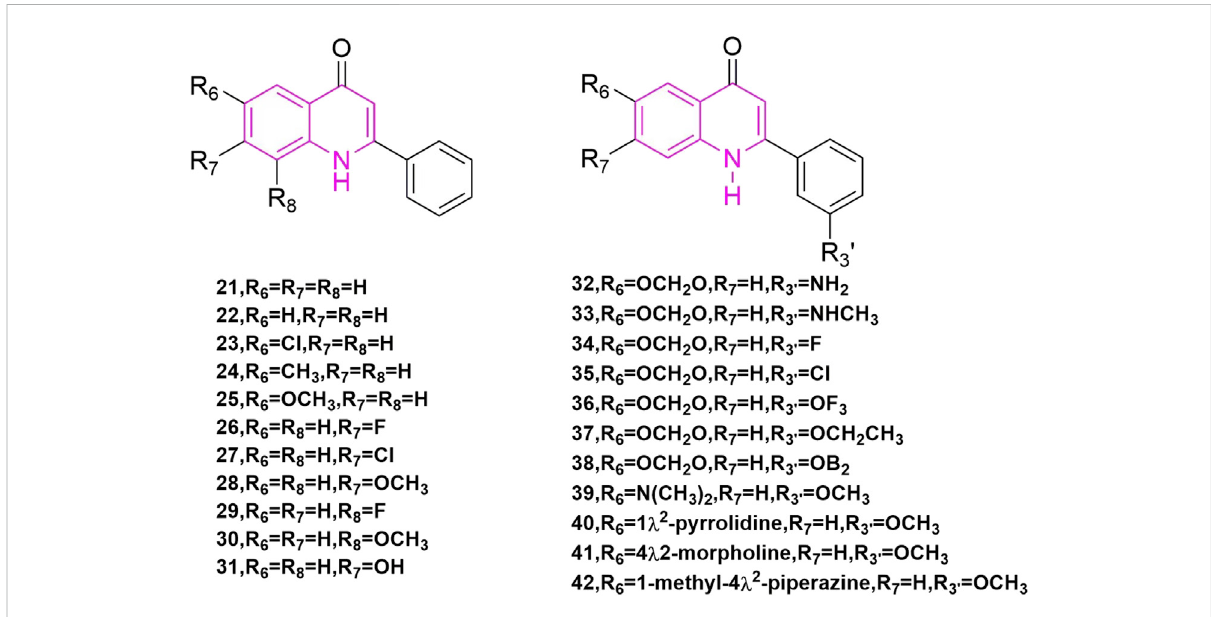
The structures of the compounds designed by Kuo et al. (1993) and Li et al.